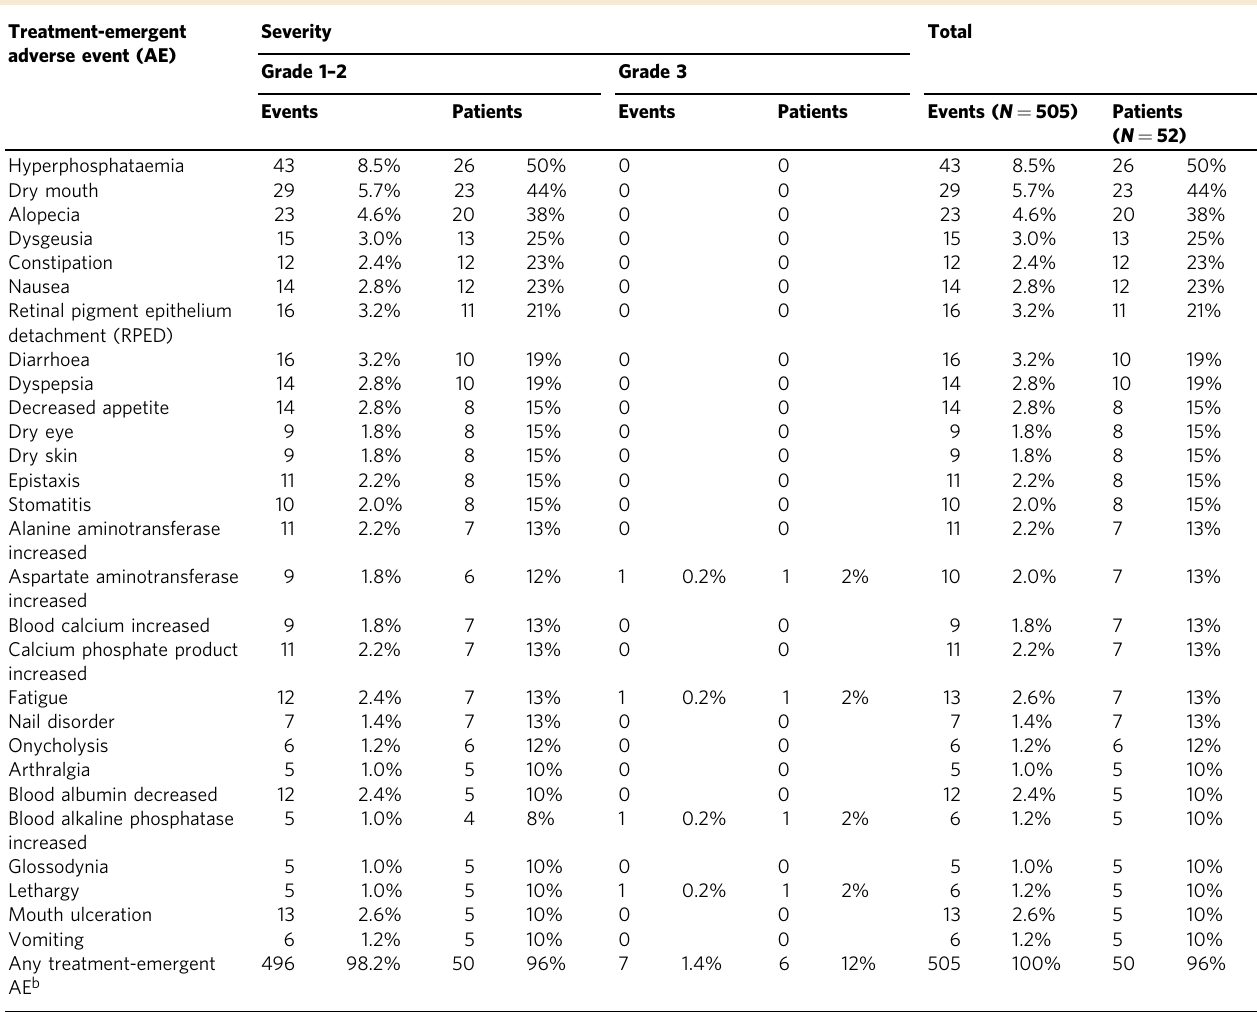
Table 2 Most frequently observed treatment-emergent adverse events a